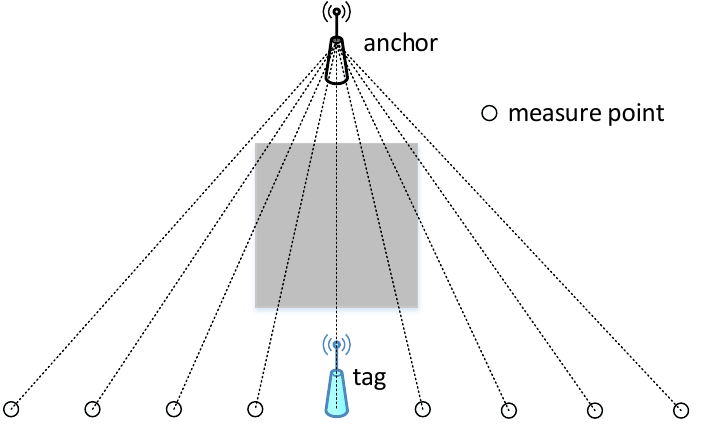
Figure A5. NLOS conditions.